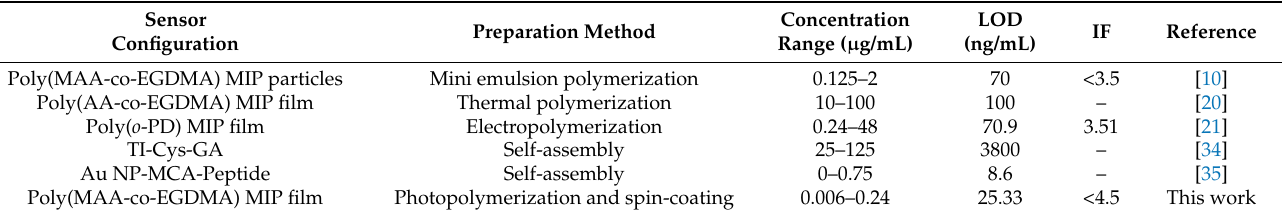
Table 1. Comparison of evaluation parameters (LOD, LOQ, and IF) for QCM sensors. Sensor